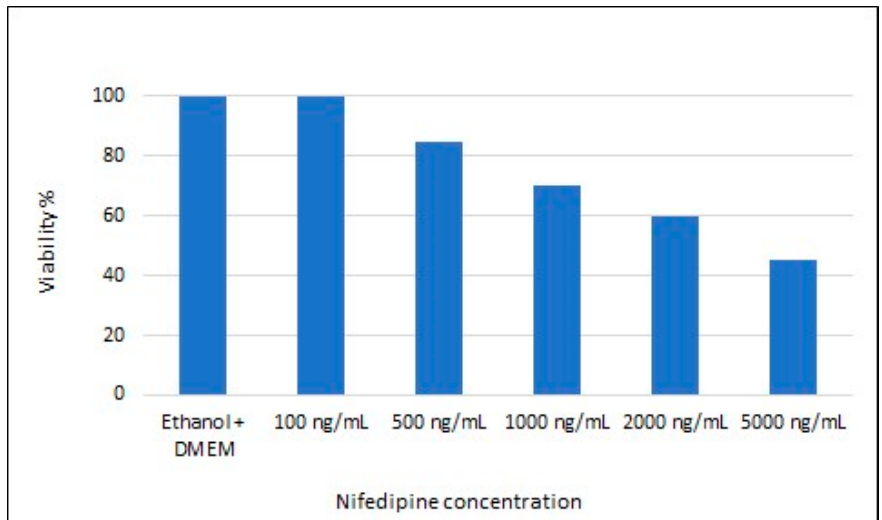
Figure 1. Nifedipine effect on cell viability.